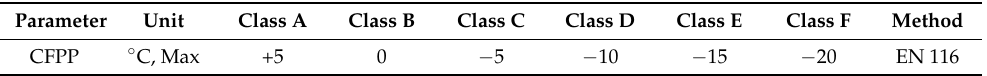
Table 9. Climatic requirements for the diesel fuel and the test methods—Mild climate. Parameter